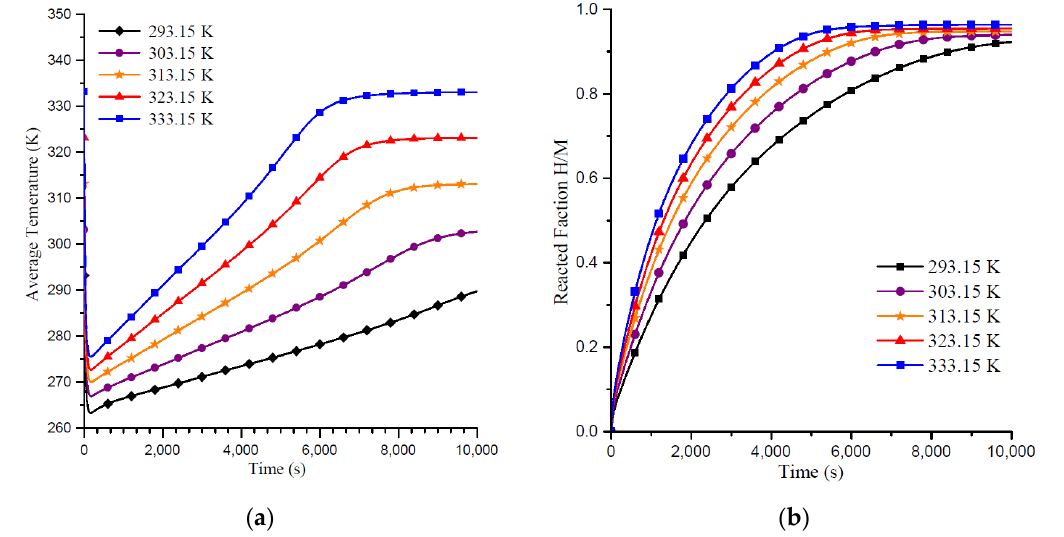
Figure 5. Time-varying curves of average temperature and reacted fraction in the reaction zone subjected to different water temperature: ( a ) average temperature; ( b ) reacted fraction. Table 3. Parameters of heat transfer